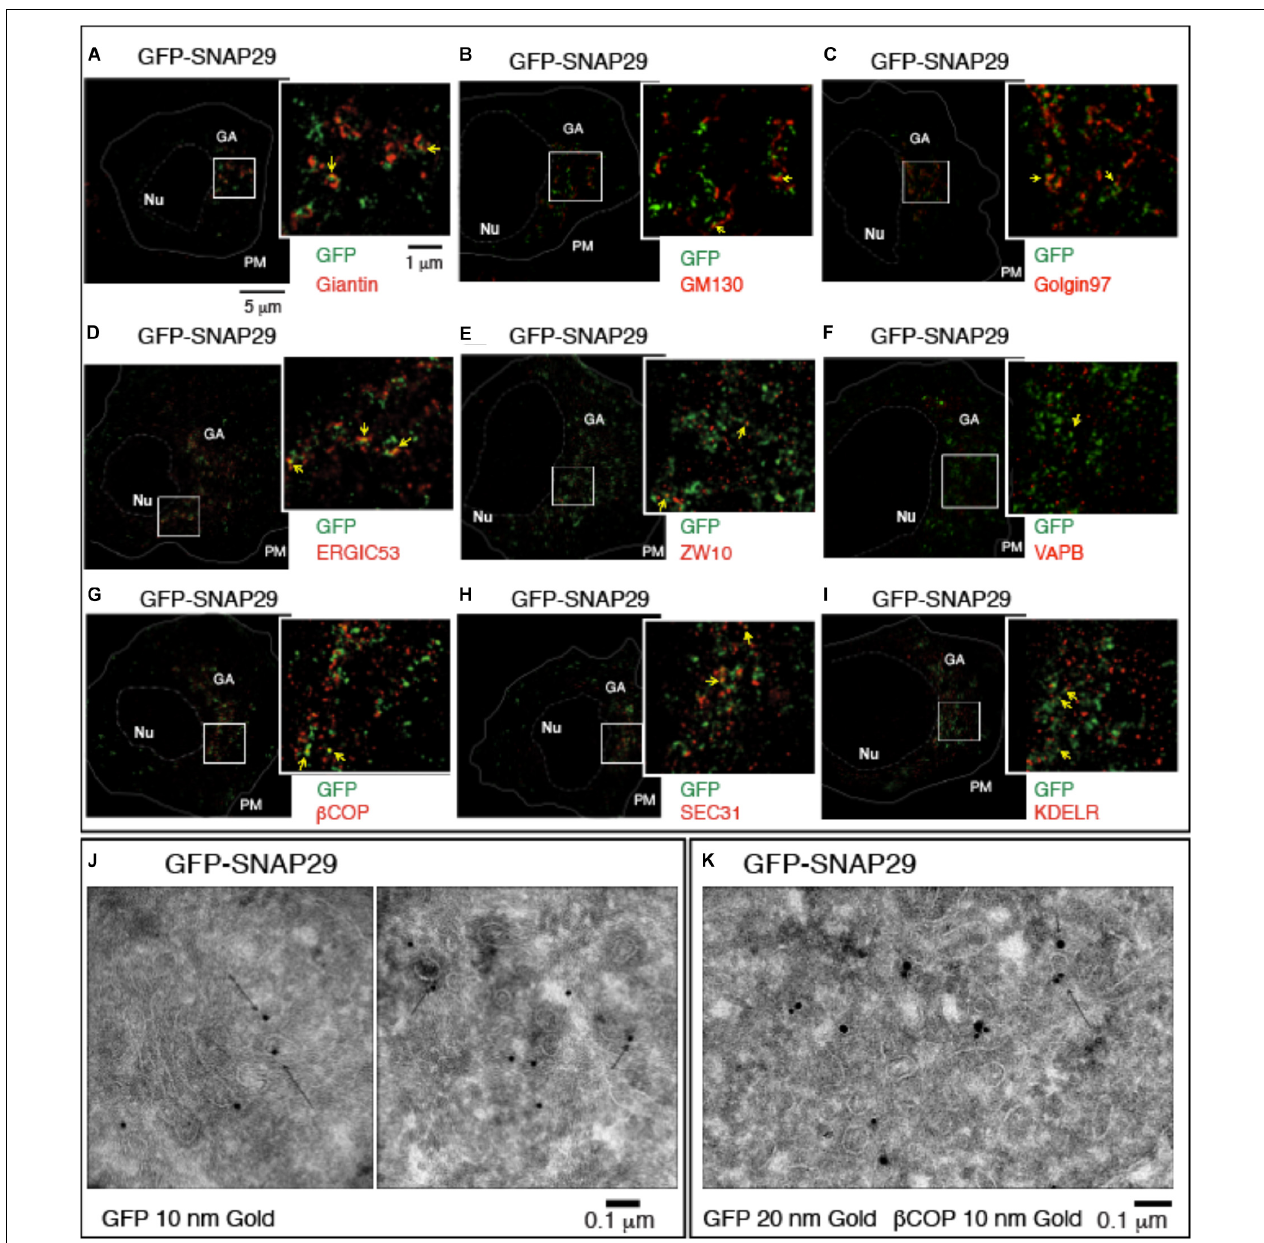
FIGURE 2 | GFP–SNAP29 partially colocalizes with endoplasmic reticulum (ER) and Golgi apparatus (GA) markers. (A–I) Single sections of HeLa cells over-expressing GFP–SNAP29 for 6 h stained as indicated and acquired by stimulated emission depletion microscopy. The dashed and the continuous lines delimit the nucleus and the plasma membrane, respectively. The boxed GA area is magnified in the insets. Yellow arrows point to an example of co-localization between GFP–SNAP29 and ER or GA markers. (J,K) Cryo-immuno-EM sections of HeLa cells stably transfected to express GFP–SNAP29, stained, and revealed as indicated. Some GFP–SNAP29 localize to the ERGIC area and colocalizes with a COPI marker.